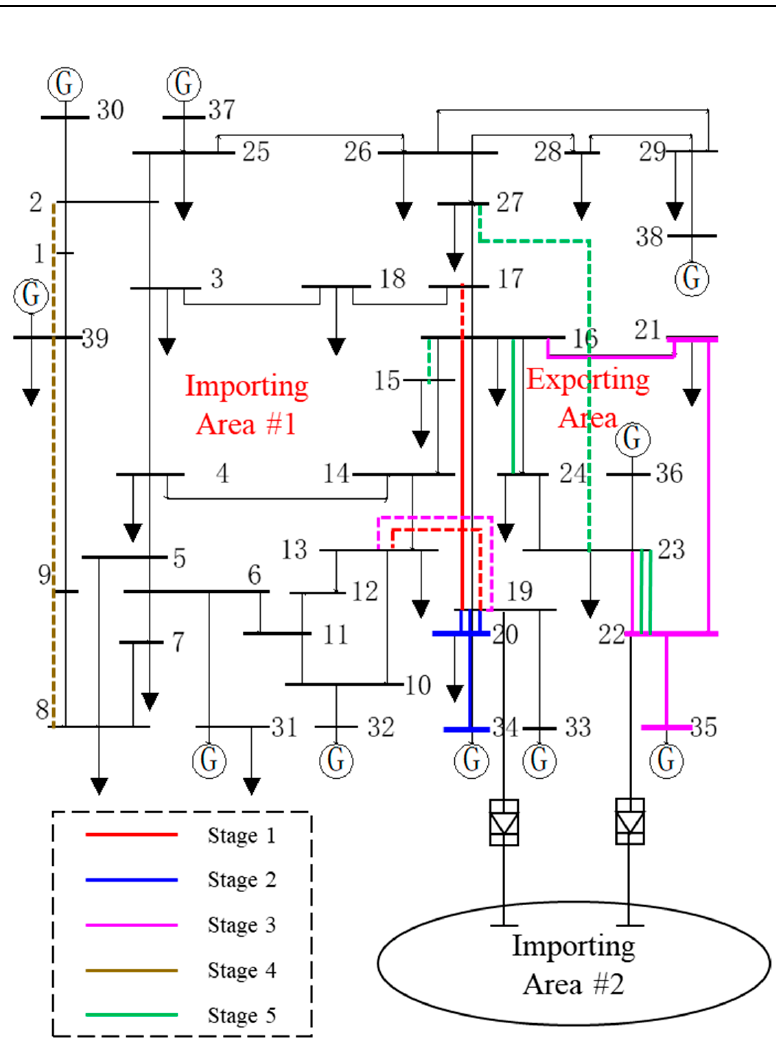
Figure 3. The network structure of the modified IEEE 39-bus system.